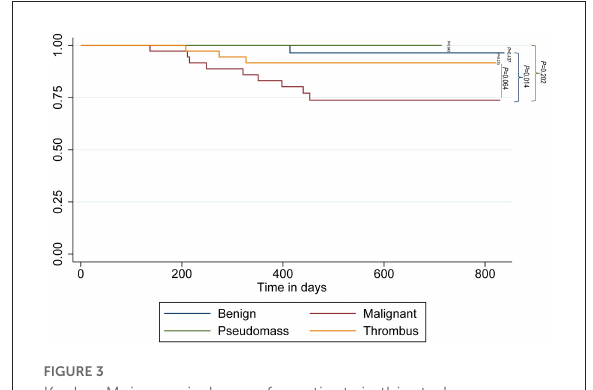
FIGURE3 Kaplan-Meier survival curve for patients in this study.